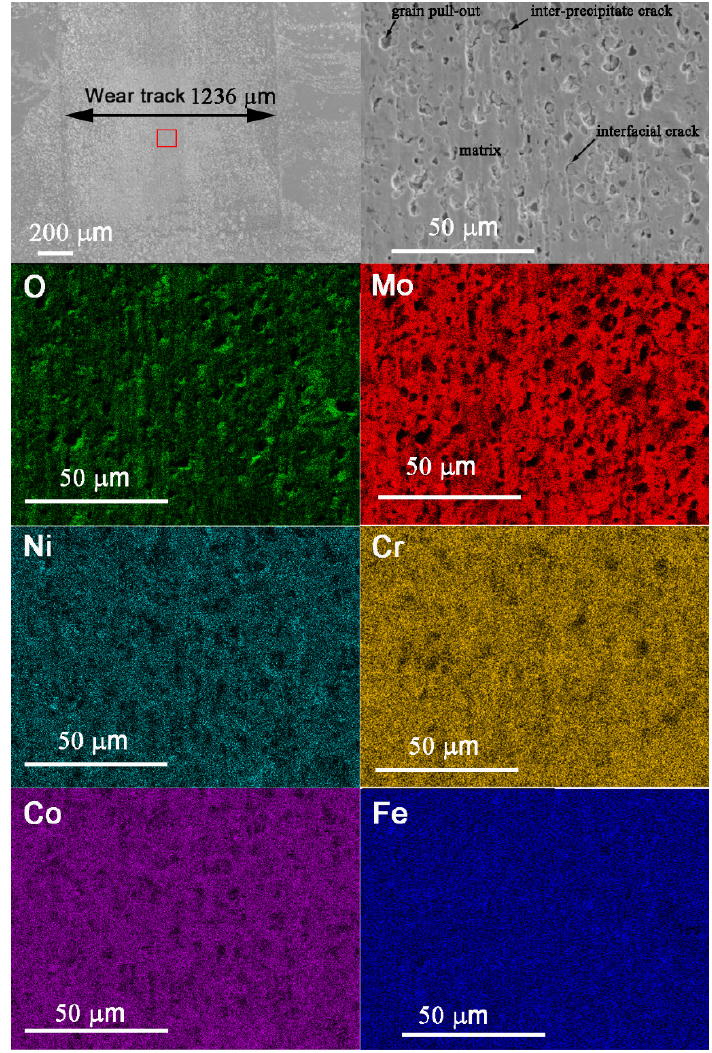
Figure 12. SEM EDS secondary electron images and elemental mapping of the wear track formed on Mo1 HEA after 240 m sliding under 20 N, the red rectangular area was further magnified to its right side.